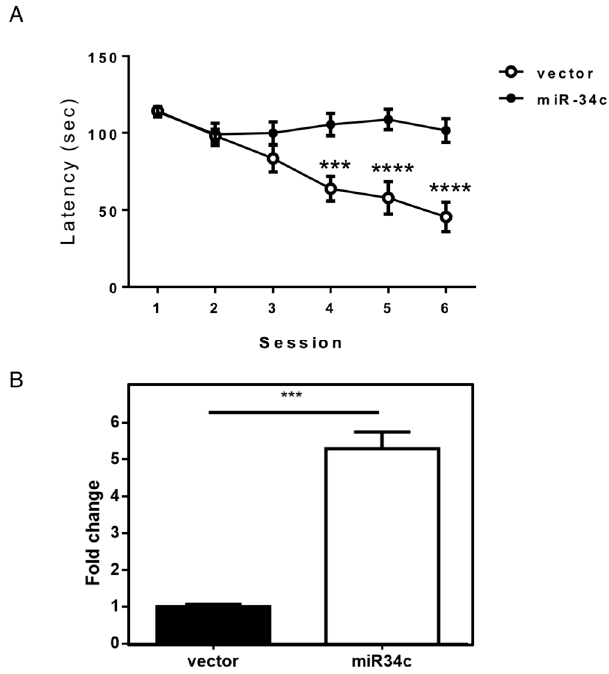
Figure 1. Overexpression of miR-34c caused memory impairment. ( A ) Escape latencies of mice overexpressing miR-34c and control vector (vec) mice ( n = 16 in each group) in the Morris water maze. The asterisks represent the level of statistical significance calculated by a two-way analysis of variance (*** p < 0.001, **** p < 0.0001); ( B ) Hippocampal miR-34c expression levels were determined by quantitative PCR in mice transfected with miR-34c construct or mice transfected with the control vector and calculated using a two-tailed Student’s t -test (*** p < 0.001).